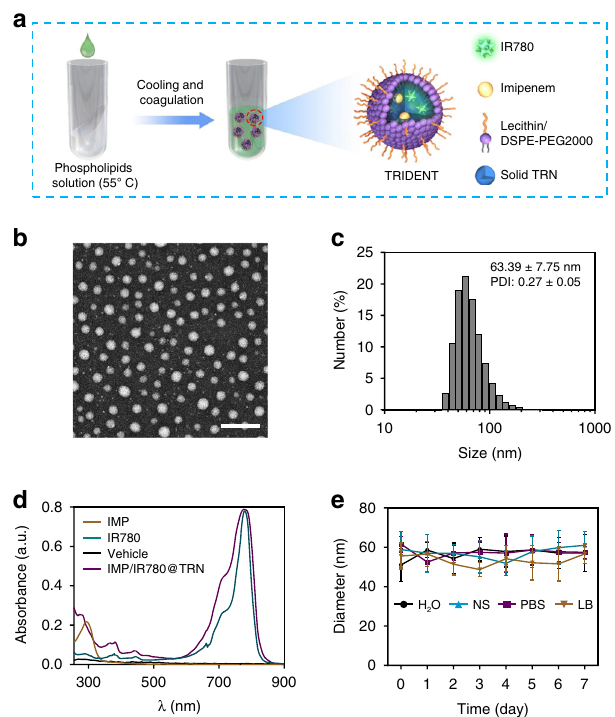
Fig. 2 Preparation and characterization of TRIDENT. a Schematic illustration of the structure of TRIDENT and its construction via modi fi ed nanoprecipitation. b Representative TEM image of TRIDENT. Scale bar: 200 nm. c Particle size distribution histograms of TRIDENT measured by DLS. d UV-vis absorption spectra of free IMP, free IR780, vehicle, and TRIDENT. e Colloidal stability of TRIDENT in different solutions. NS normal saline, LB lysogeny broth. Data are presented as mean ± s.d. ( n = 4). Source data are provided as a Source Data fi